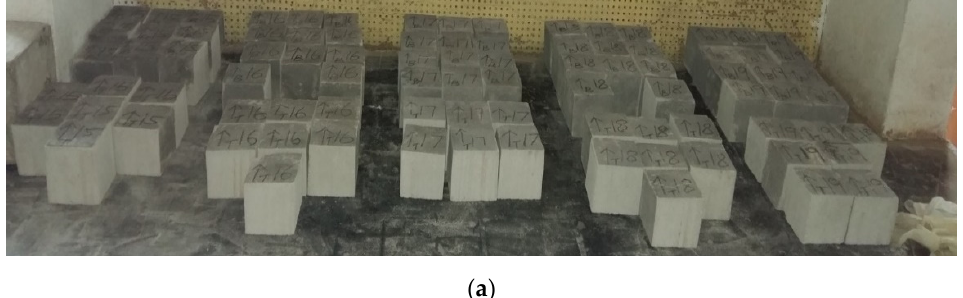
Figure 9. Flow chart of the AAC Specimen Preparation Process.